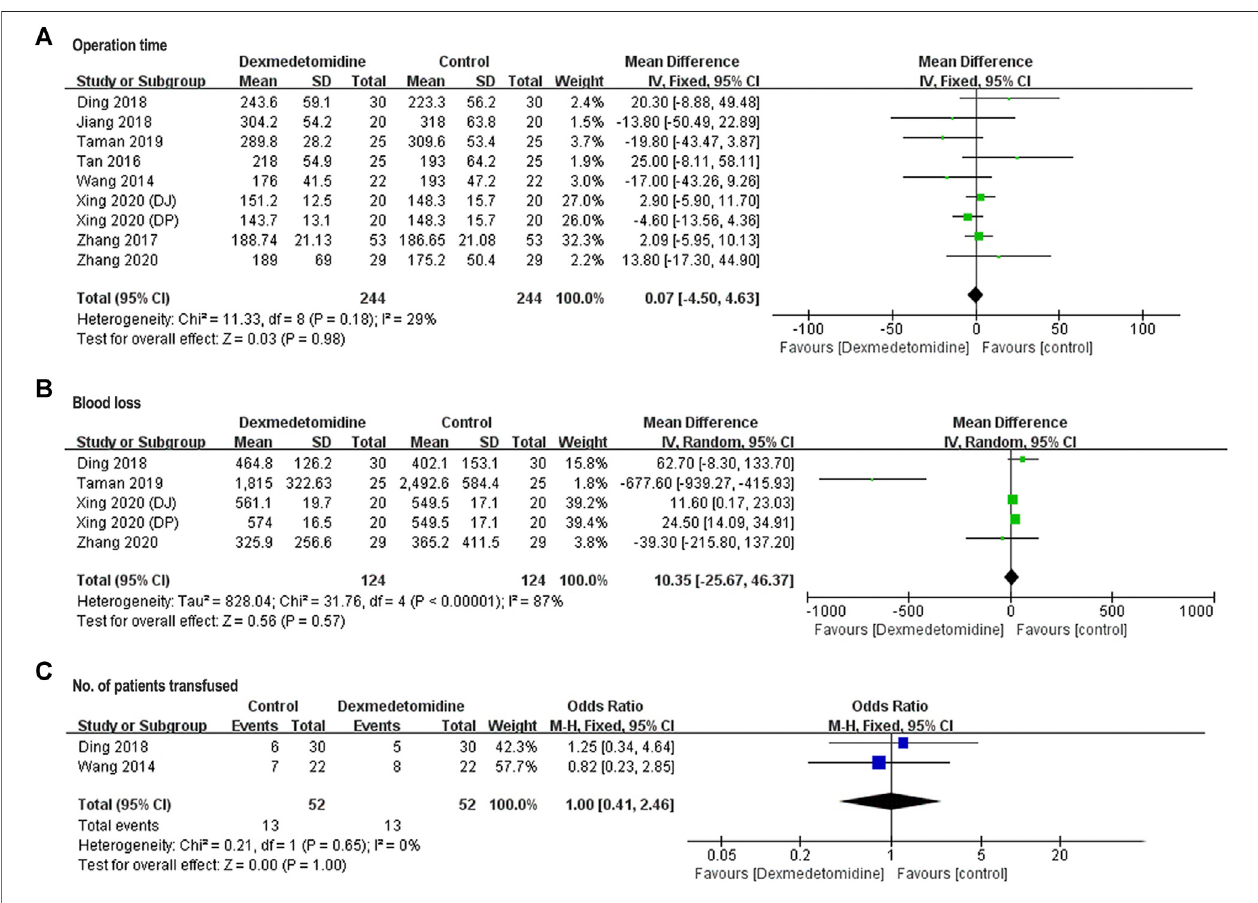
FIGURE 6 | Forest plots for meta-analyses comparing operation time (A) , blood loss (B) , and No. of patients transfused (C) .